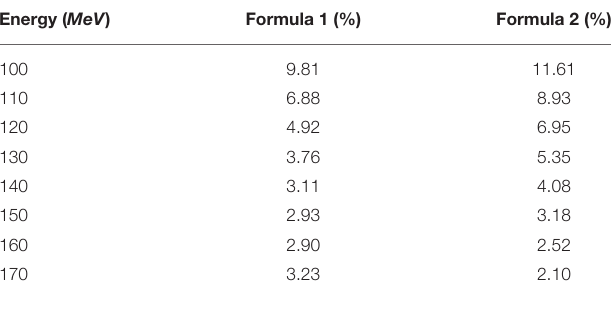
TABLE 1 | The percentage differences of WD for formulas 1 and 2 for simulations.